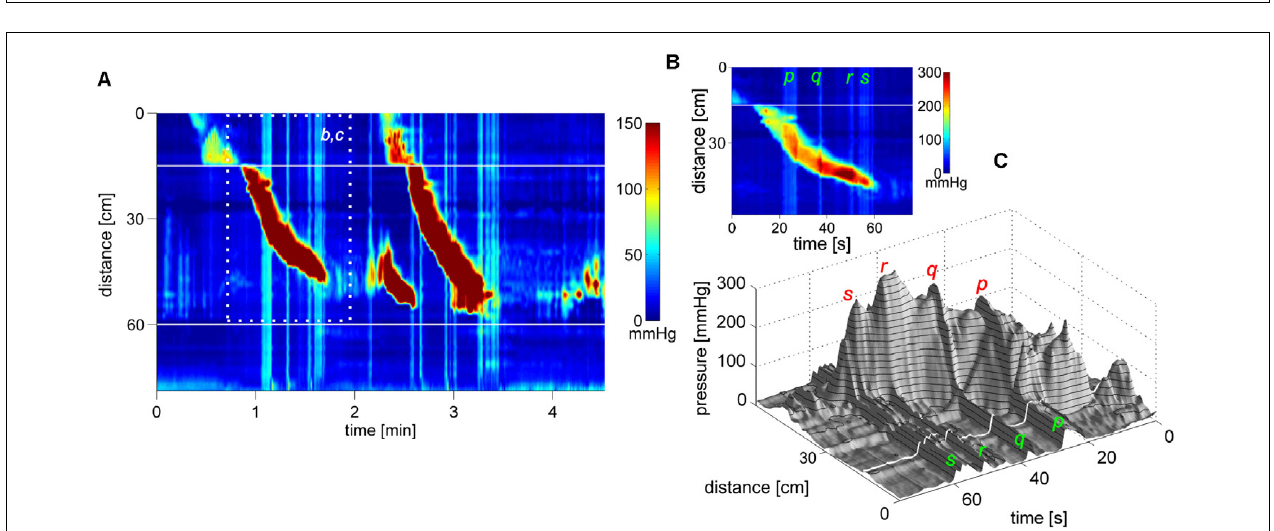
FIGURE 13 | Independent HAPWs and SPWs show addition of pressure. (A) Concomittant occurrence of HAPWs and SPWs. The anal sphincter pressure is not shown. (B) A closeup of one of the HAPWs with unrelated SPWs. (C) The 3D graph of (A) shows that the pressures of the HAPW and the SPWs add up. This activity started 8 min after injecting 20 mg bisacodyl suspension in the descending colon. There was no outflow